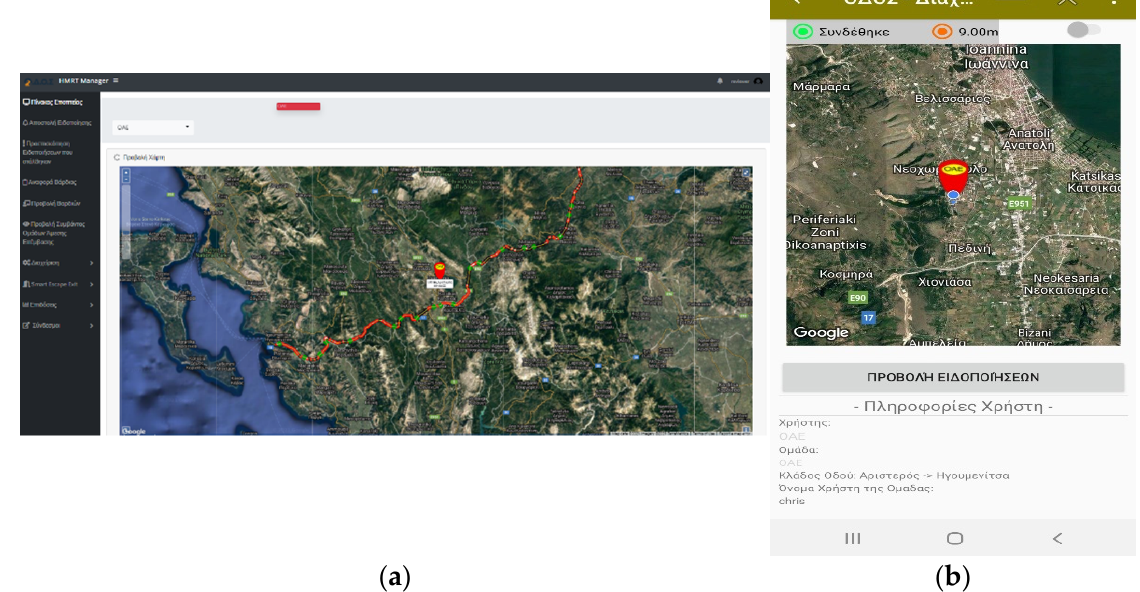
Figure 2. The resources management system consists of ( a ) information system; ( b ) Android appli- cation.